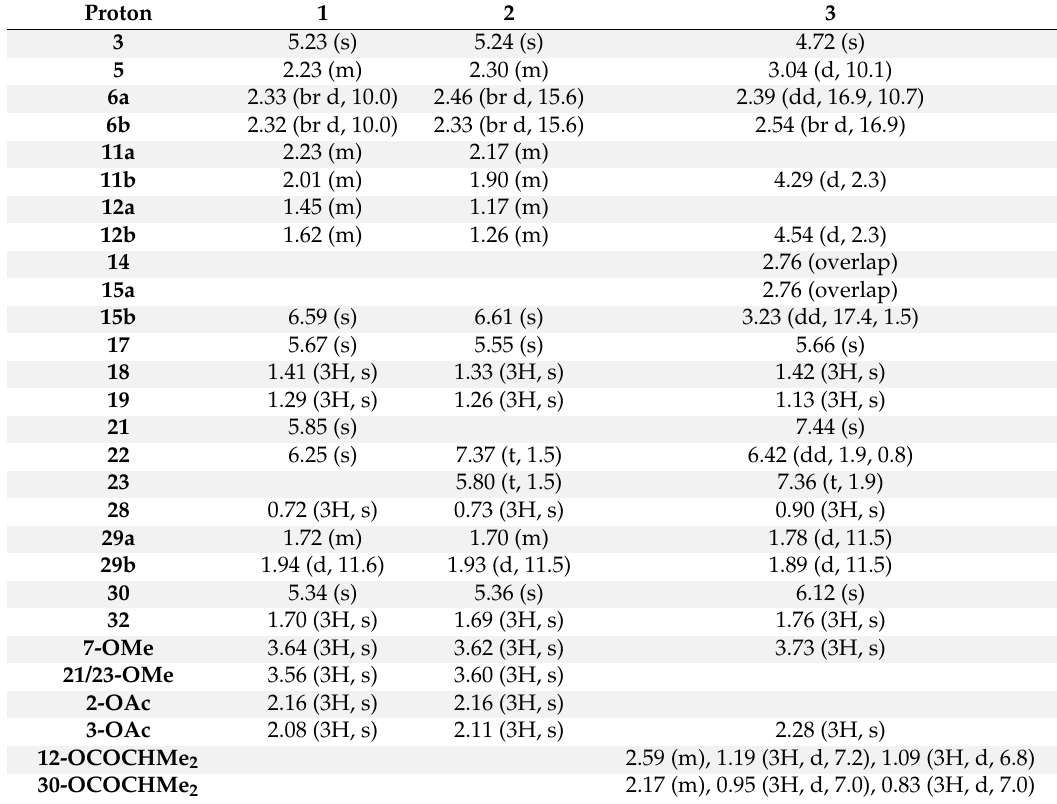
Table 1. 1 H-NMR (500 MHz) data of compounds 1 – 3 (CDCl 3 , δ H in ppm, J in